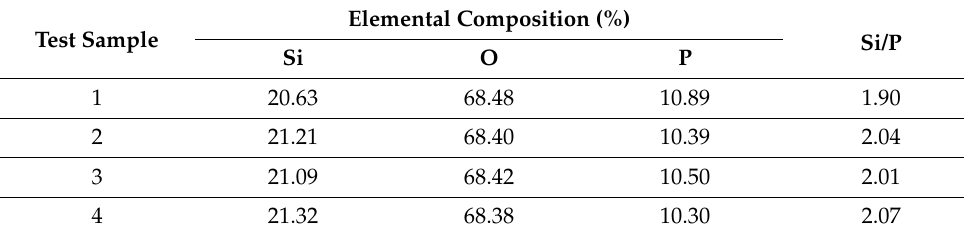
Table 3. Elemental composition of the EAPP particles.